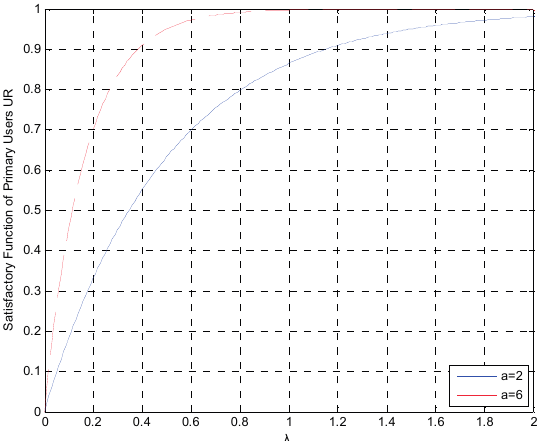
Figure 2. The relationship with different satisfactory factor a between the satisfaction function of the primary user and the ratio of the transmission rate to the traffic requirement λ